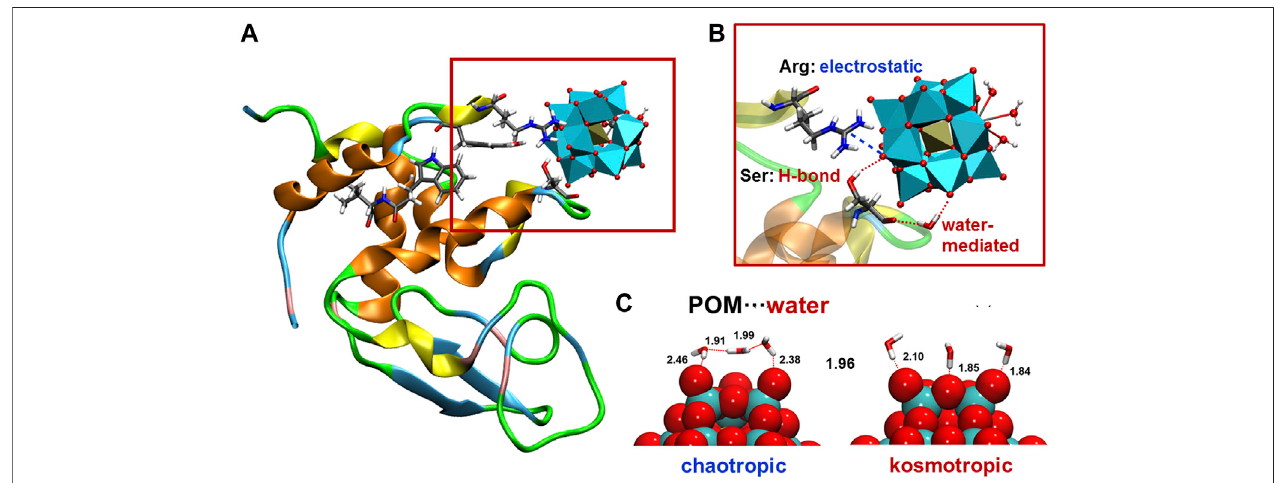
FIGURE 1 | (A) Illustrative snapshot of the interaction between HEWL protein and Ce-substituted Keggin POM [ref (Solé-Daura et al., 2016)]; (B) closer look highlighting interaction with individual amino acids of different nature type (electrostatic, hydrogen-bonding, and water-mediated); (C) representative snapshot of the waterdistribution around two POMs ofdifferentcharge density [moderately and highly charged for chaotripic and komostropicPOM ··· waterinteraction, respectively,ref (Solé-Daura et al.,